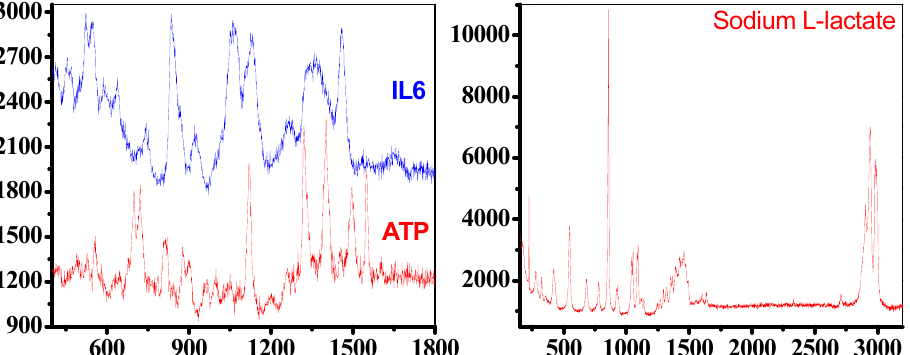
Figure 6. Left: Raman spectra for ATP (red) and IL6 (blue), measured between 500 and 1800 cm − 1 , Right: Raman spectra for Sodium L-Lactate, measure between 100 and 3300 cm − 1 , (information on the enhancement factor can be found in the supplementary material)